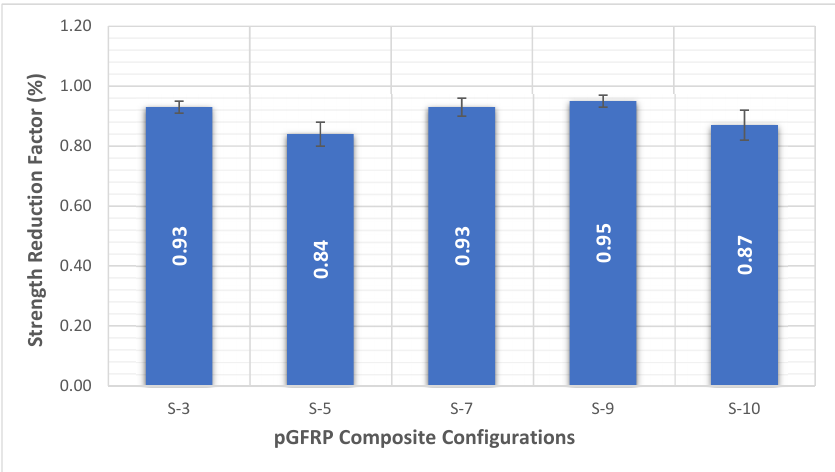
Figure 8. Average strength reduction factor in 1440 h (60 days).